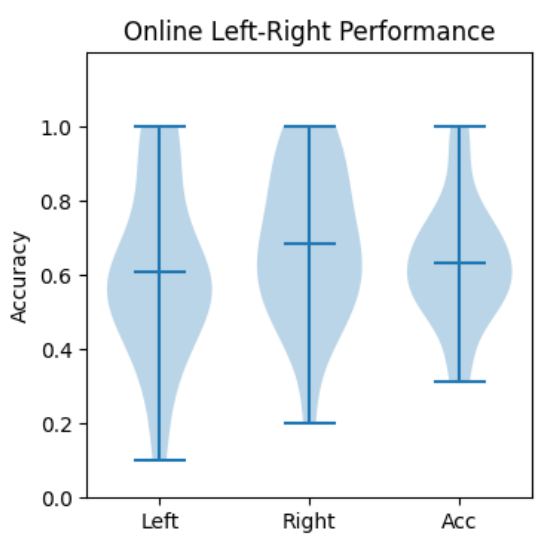
Figure 11. Online decoder’s performance.